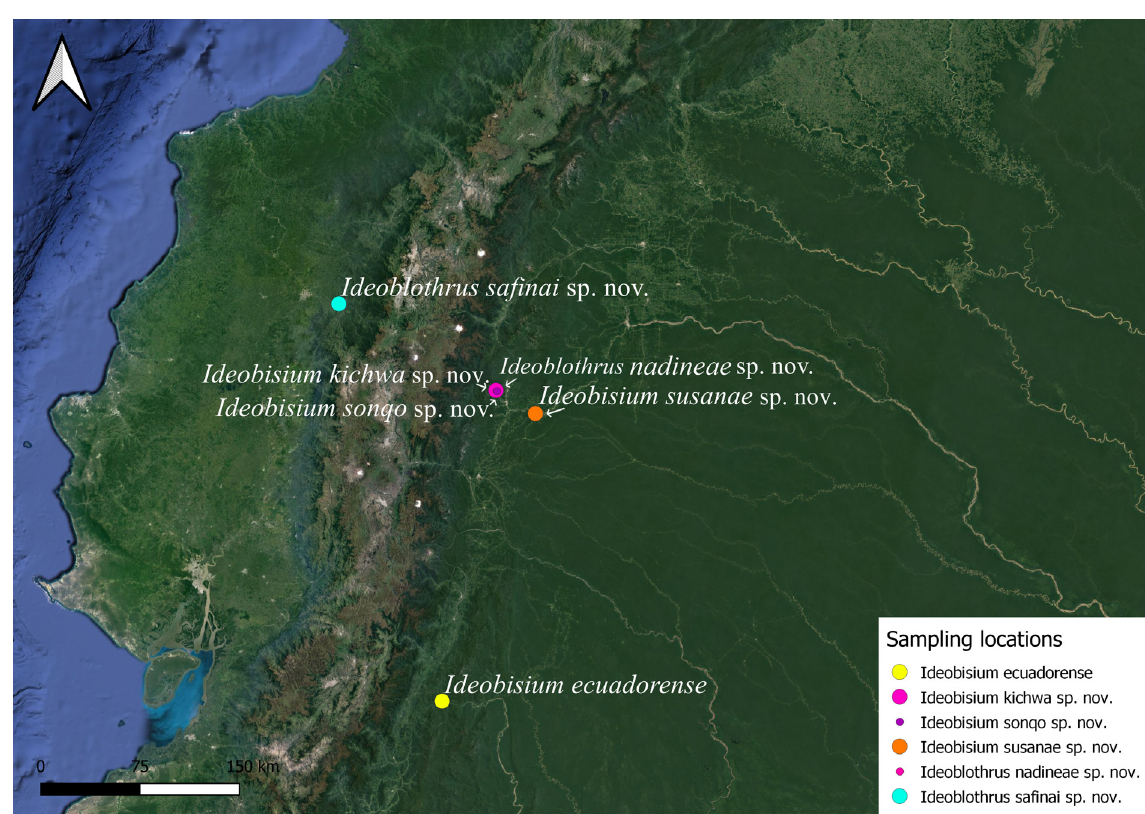
Fig. 2. Map indicating all sampling locations in Ecuador used for this study. The locations for the newly described species are shown, as well as the type locality of Ideobisium ecuadorense Muchmore,